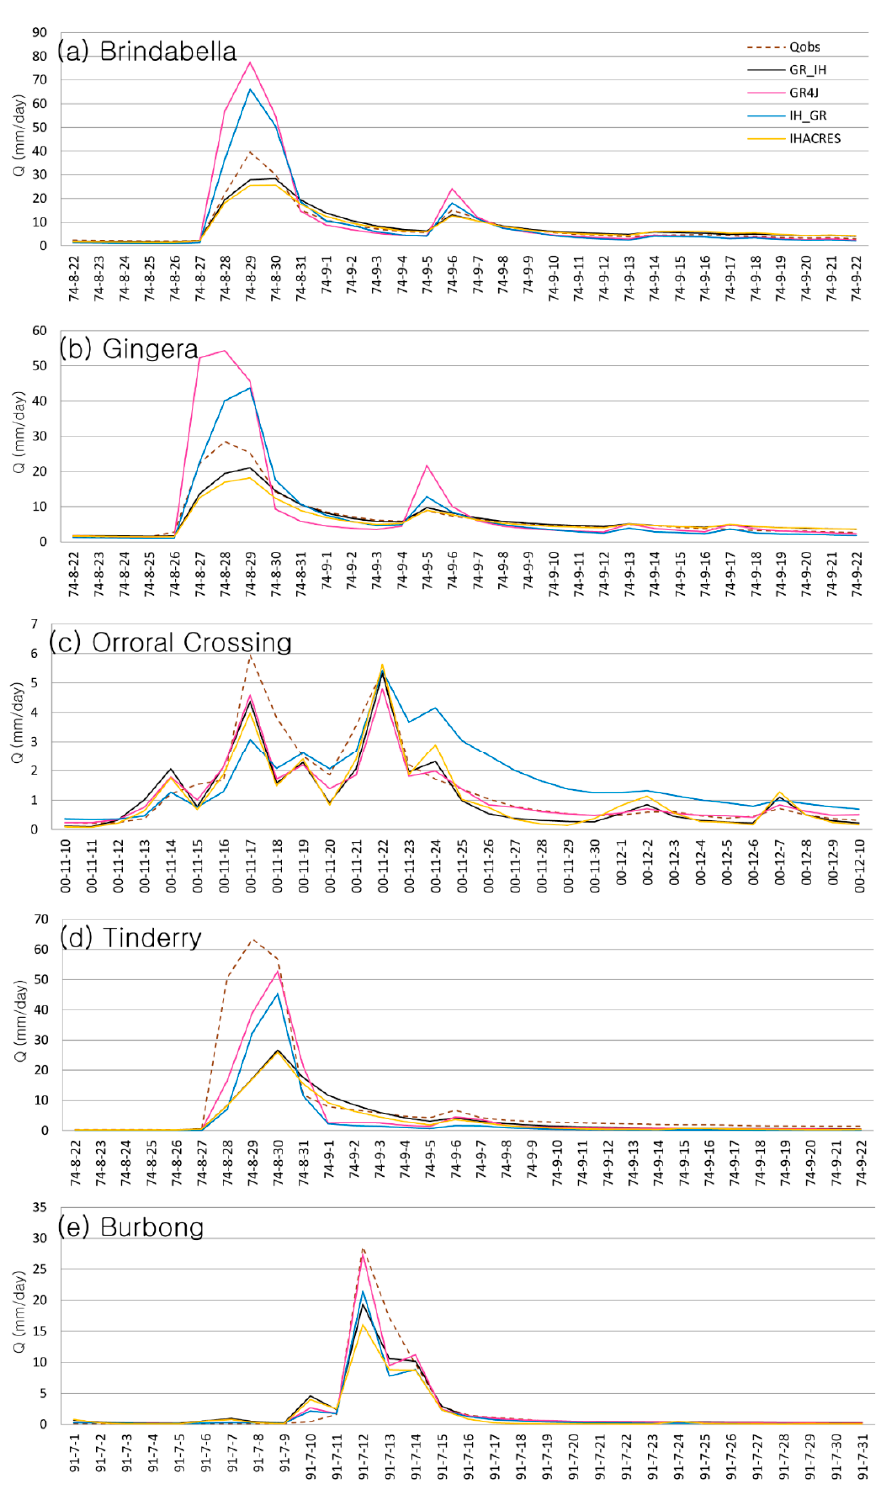
Figure 2. Comparison of the hydrographs of the four rainfall–runoff models for the maximum events with respect to the NSE objective function: ( a ) validation of the 1970s with the calibration of the 2000s for the Brindabella (wet) catchment, ( b ) validation of the 1970s with the calibration of the 2000s for the Gingera (wet) catchment, ( c ) validation of the 2000s with the calibration of the 1970s for the Orroral Crossing (intermediate) catchment, ( d ) validation of the 1970s with the calibration of the 2000s for the Tinderry (dry) catchment, and ( e ) the validation of the 1990s with the calibration of the 1980s for the Burbong (dry) catchment.